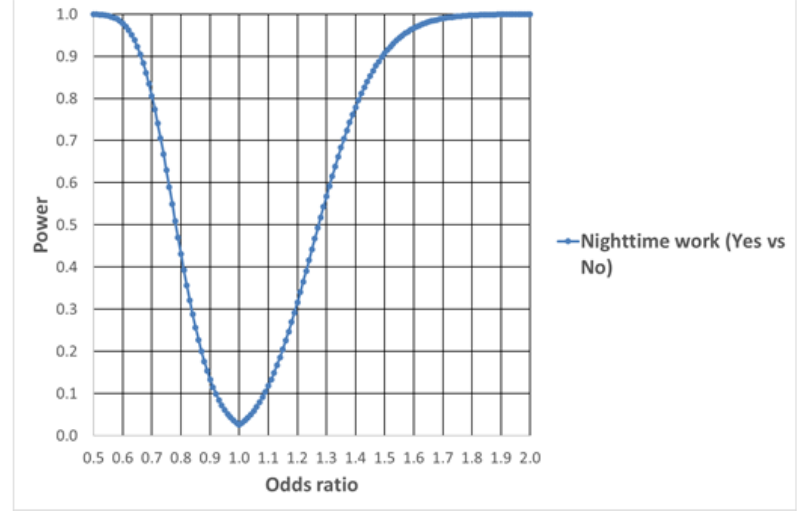
Figure 7. Power to detect an effect of night shift work on the odds of psychiatric hospital treatment for mood disorders vs anxiety disorders and stress-related disorders, as a function of underlying odds ratios ( α =